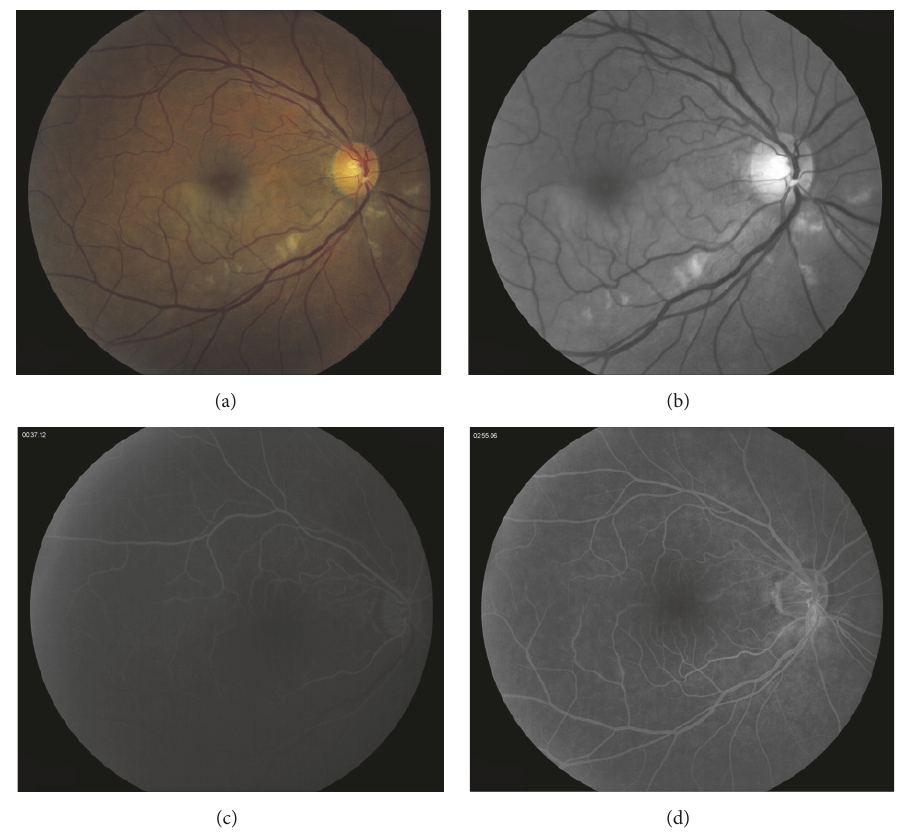
Figure 1: Color fundus photograph of the right eye at initial presentation where BCVA was 20/20 (a) demonstrating the site of occlusion with the emboli situated in a branch of the central retinal artery on the optic disc. Inferior retinal whitening was visible. Red free (b) photograph of the right eye at initial presentation. Fluorescein angiography at 37 seconds (c) showing delayed arterial filling along the inferior retinal vascular arcade. Fluorescein angiography at 2 minutes and 55 seconds (d) showing mild hyperfluroescence along the vessels emanating from the inferior optic